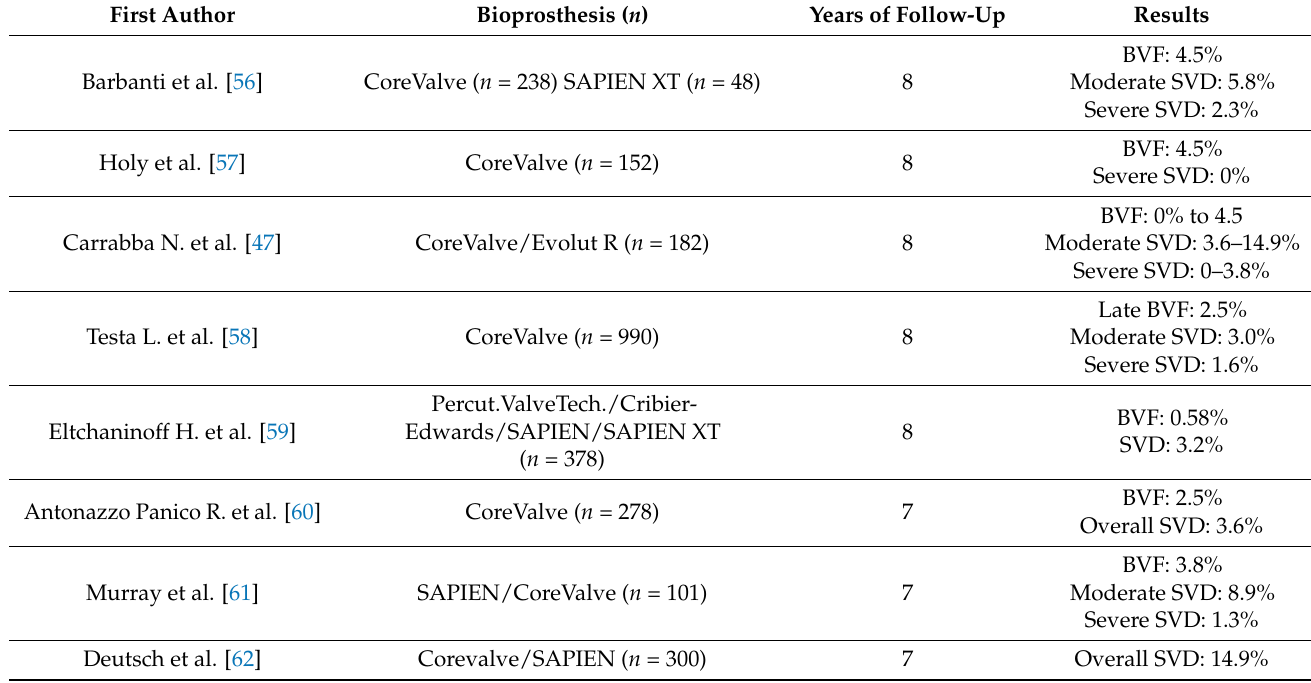
Table 1. Long-term TAVI durability from the recent